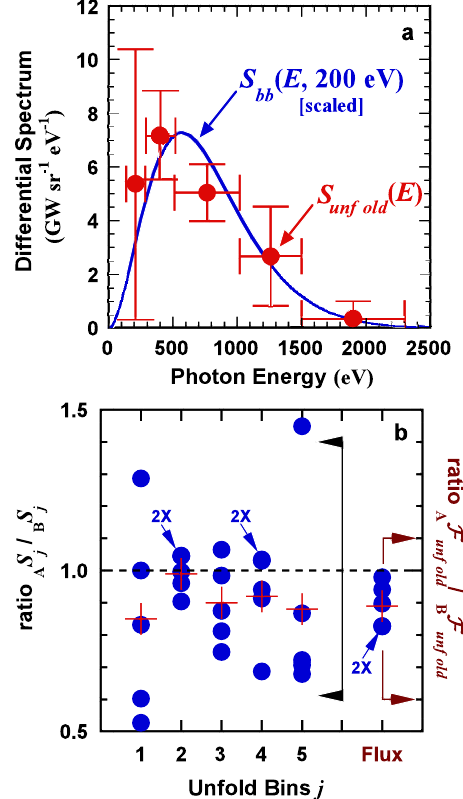
FIG. 2. Estimated experimental uncertainties for the Z diag- nostic, and fluctuations for repeated experiments. Part (a) shows the unfolded peak-power spectrum for Z -shot 165 (cf. Pt. 1: Figs. 3 and 4). Here, for clarity, S unfold ð E; t peak Þ is denoted by solid (red) points at the midpoint of each unfold bin (Pt. 1: Table II), with horizontal bars indicating the bin widths; the ordinates [ GW sr (cid:4) 1 eV (cid:4) 1 ] are the unfold coefficients, S j . Vertical error bars give the combined, propagated uncertainties, (cid:13) (cid:3) ð (cid:1) S j Þ . The blue curve is a 200-eV Planckian spectrum [ GW sr (cid:4) 1 eV (cid:4) 1 cm (cid:4) 2 ] scaled by integrated flux to the same units. Part (b) compares unfold coefficients and flux for two independent, filtered-XRD arrays (denoted ‘‘A’’ and ‘‘B’’), which were simultaneously fielded on five, nominally identical, tungsten z -pinch shots at the Z facility ( Z -shots 163-167). The solid points are the binwise unfold ratios, A S j = B S j , for each shot at peak power (left scale); the additional points at the right side of the figure are the corresponding unfold flux ratios, F = F B A unfold unfold (right axis, same scale). The notation ‘‘2X’’ indicates two nearly identical ratios; and the red ‘‘ þ ’’ symbols denote the sample ratio mean for each bin j and the flux